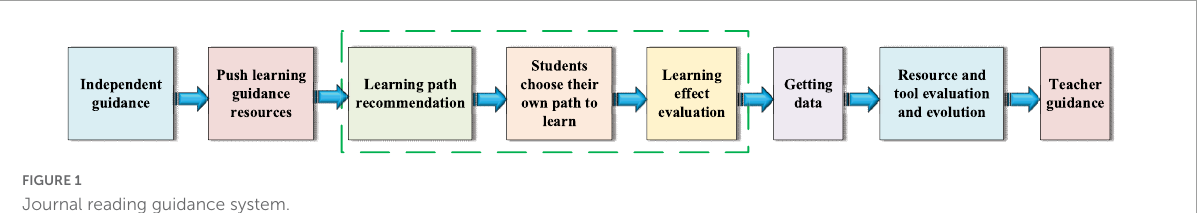
FIGURE1 Journal reading guidance